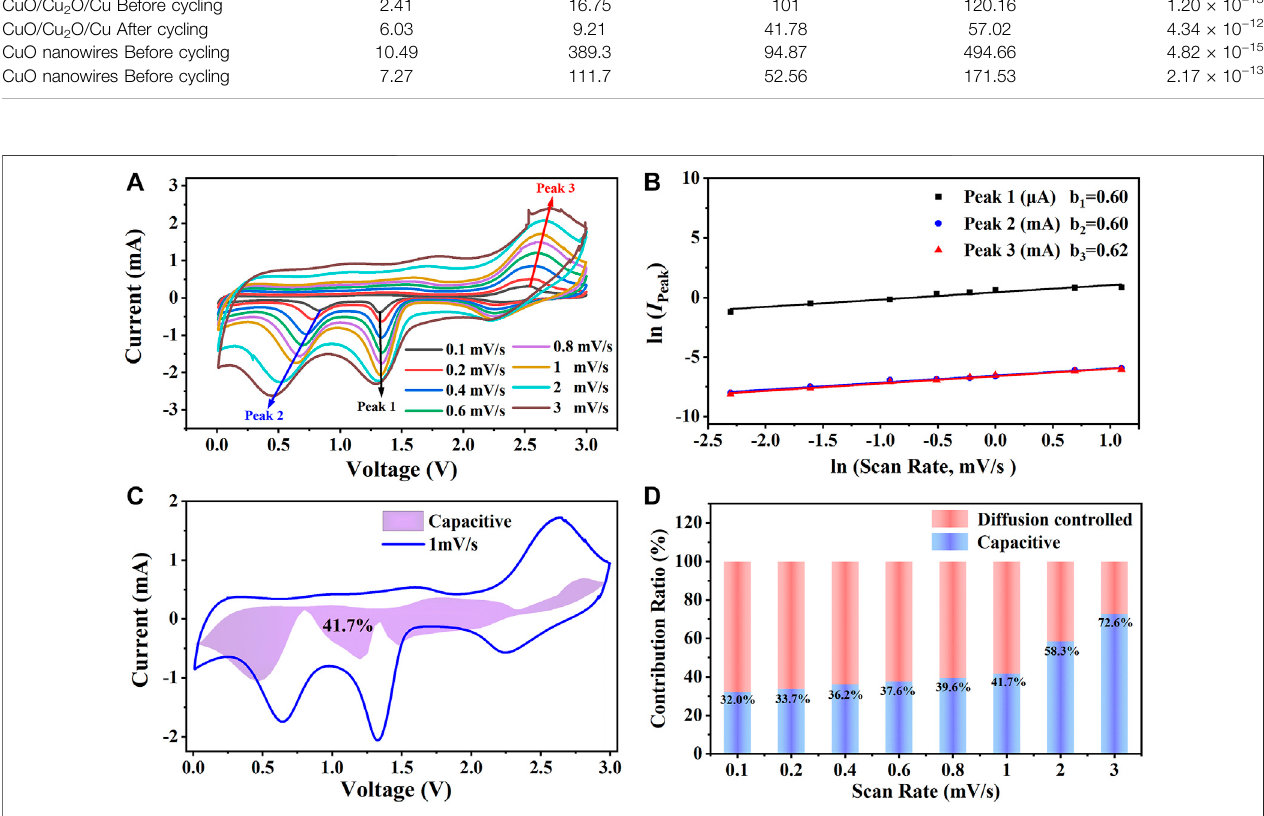
FIGURE 7 | (A) The cyclic voltammetry curves of CuO/Cu 2 O/Cu nanocomposites with different scan rates. (B) The linear fi tting results of log ( I Peak ) vs. log( ] ). (C) Capacitive contribution at 1 mV/s. (D) Capacitive contributions to the lithium-ion storage at different scan rates.